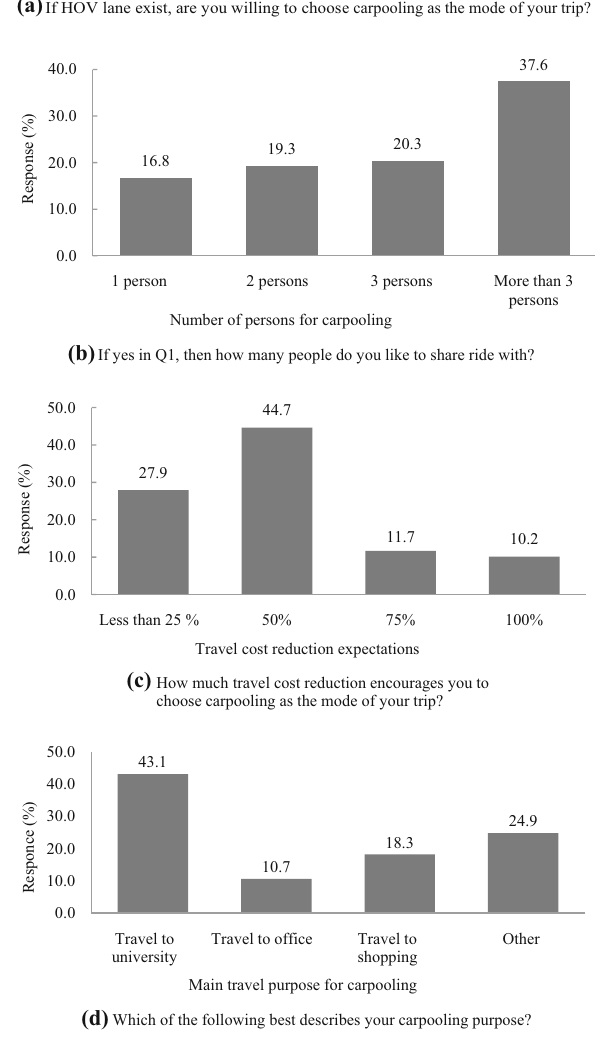
Fig. 1 Distribution of responses on various carpooling